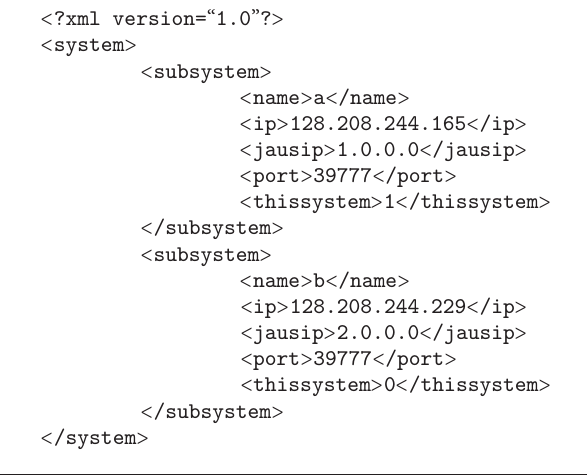
Algorithm 1: JAUS configuration